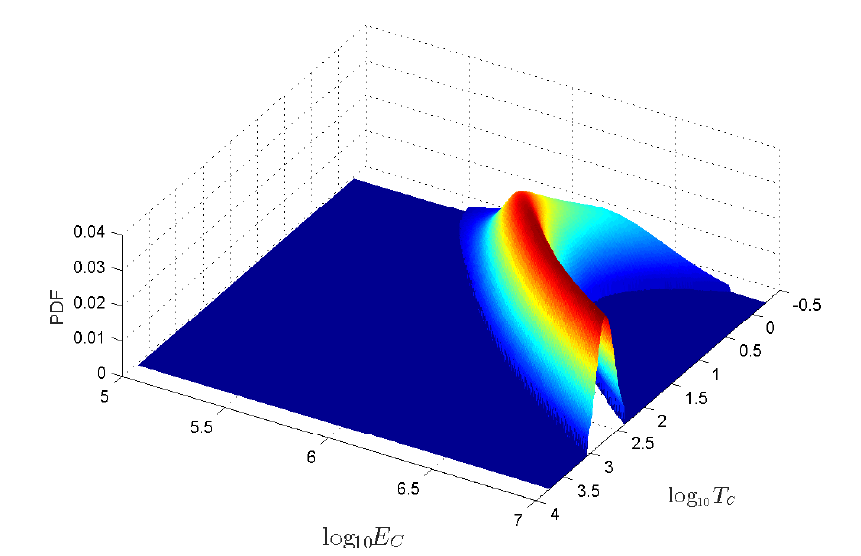
Figure 10. Thermal tripping probability distribution of the “Square D QOB-3100” circuit breaker.